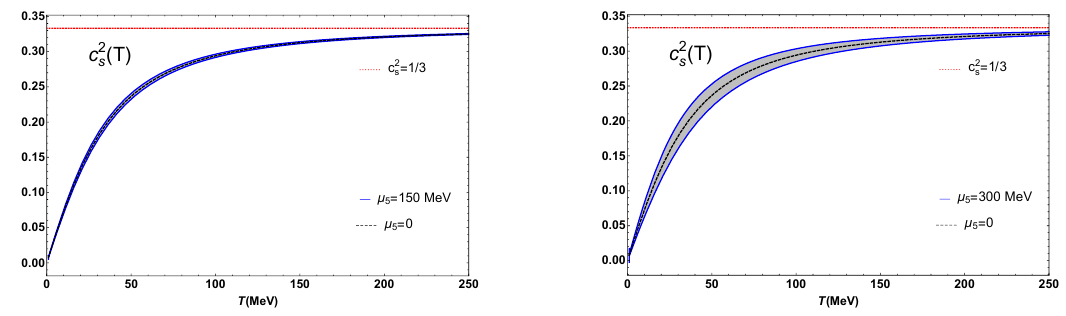
Figure 9 . Speed of sound squared for (cid:22) 5 = 150 MeV and (cid:22) 5 = 300 MeV compared to the (cid:22) 5 = 0 case. The uncertainty bands correspond to j (cid:20) b j (cid:20) 1 16 (cid:25) 2